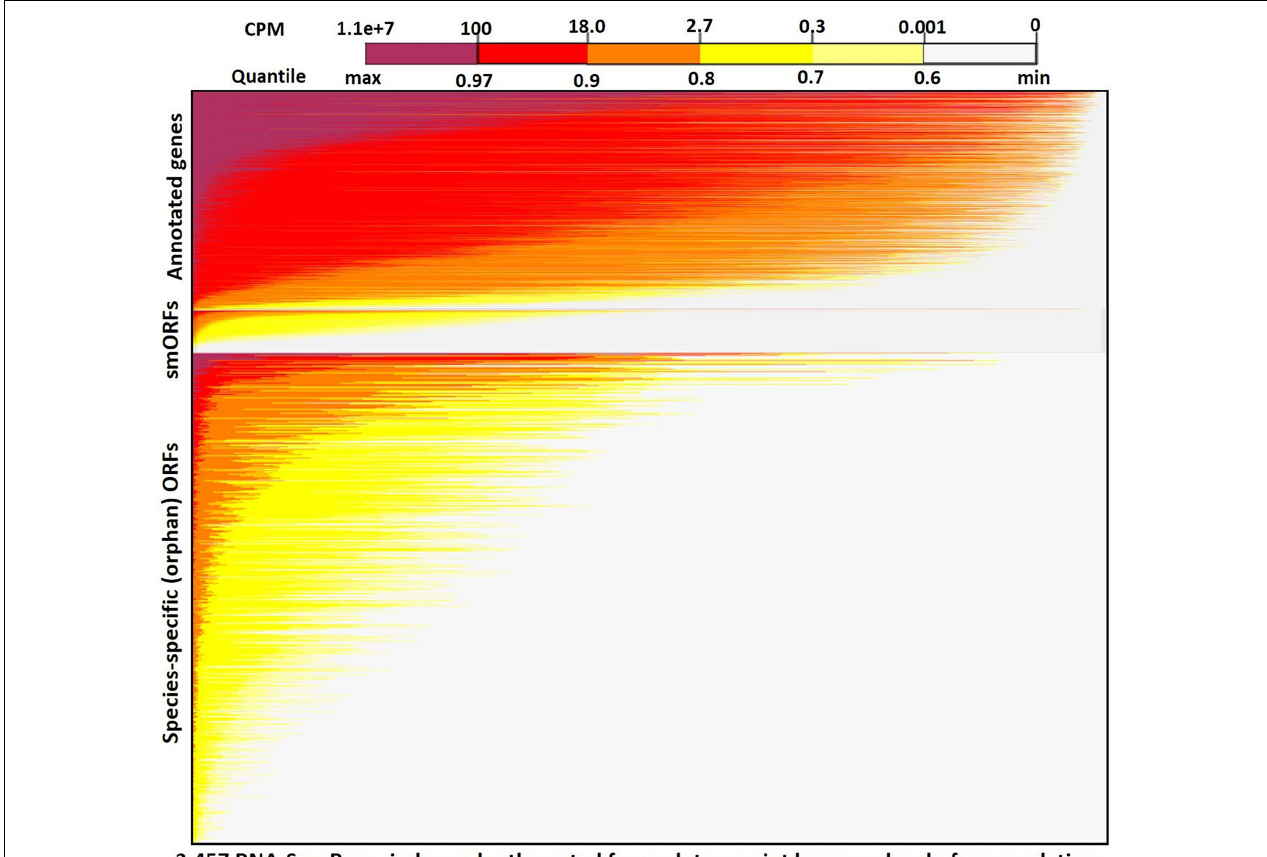
FIGURE 2 | RNA-Seq expression heatmap across 3,457 samples for orphan-ORFs and annotated genes. Top panel, annotated genes (6,692); middle panel, small translated sequences (smORFs) (Carvunis et al., 2012) (1,139); bottom panel, orphan-ORFs (15,805) (see Supplementary Figure 9 for full results). Each row represents a transcript. Within a panel, each transcript is ordered by its mean cpm. Within each row, the 3,457 samples are sorted independently by highest expression of the transcript. The restricted conditions of expression of many orphan-ORFs is visually apparent.